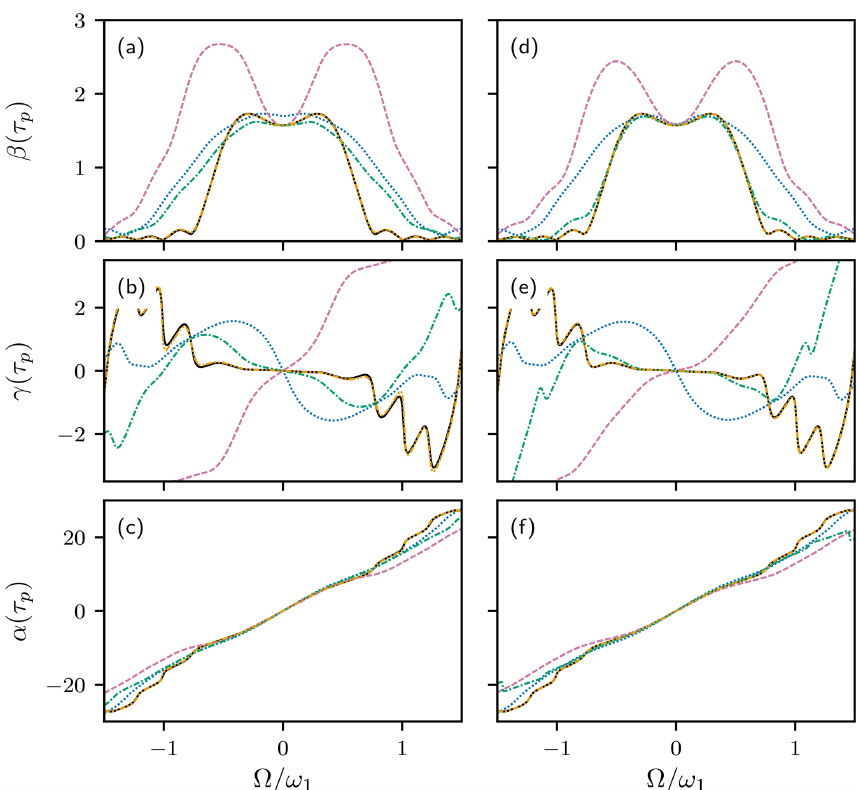
Figure 2. HAM approximations for 90 ◦ EBURP-2 pulse. Numerical calculation of Euler angles α ( τ p ), β ( τ p ), and γ ( τ p ) using Eqs. (1)– (3) (black line). First-order (blue dotted line), second-order (reddish-purple dashed line), third-order (green dash-dotted line), and fifth-order (orange dash–dot–dotted line) HAM results, using method 1. Results are shown for (a, b, c) c 0 = − 1 and (d, e, f) c 0 = − 0 . 925. The numerical calculation and fifth-order HAM curves are nearly